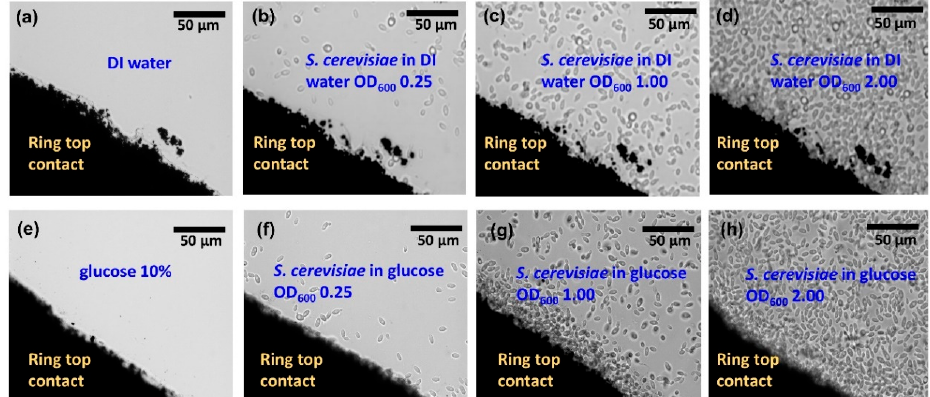
Figure 2. Top view optical microscopic images of a section of ring electrode (dark)on glass (bright) with ( a ) DI water, ( e ) glucose, S. cerevisiae in ( b ) DI water, ( f ) glucose at OD 600 0.25, S. cerevisiae in ( c ) DI water ( g ) in glucose at OD 600 1.00, S. cerevisiae in ( d ) DI water and ( h ) in glucose at OD 600 2.00 in the ring top electrode region. Here a transparent glass substrate has been used to illuminate the sample with light from the backside. The thickness of the ring top electrodes is 150 nm and is large enough to keep inserted liquid in the ring top